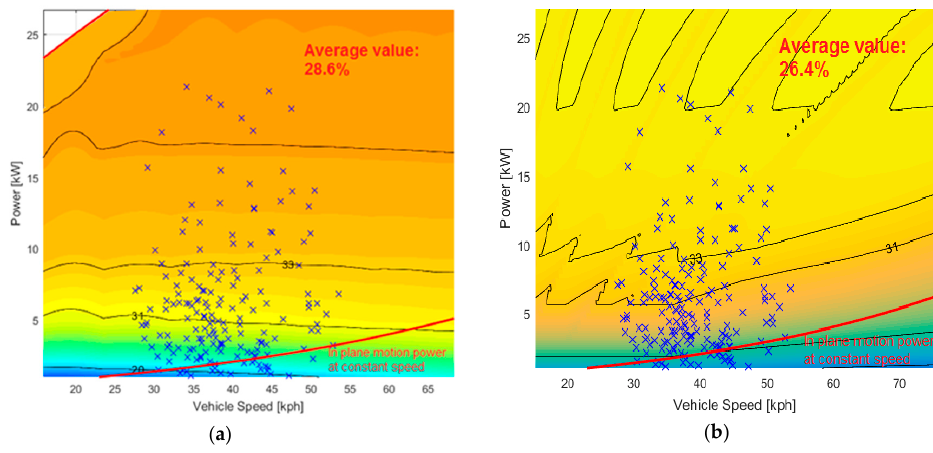
Figure 17. Urban mission work points: ( a ) CVT ; and ( b ) DVT .